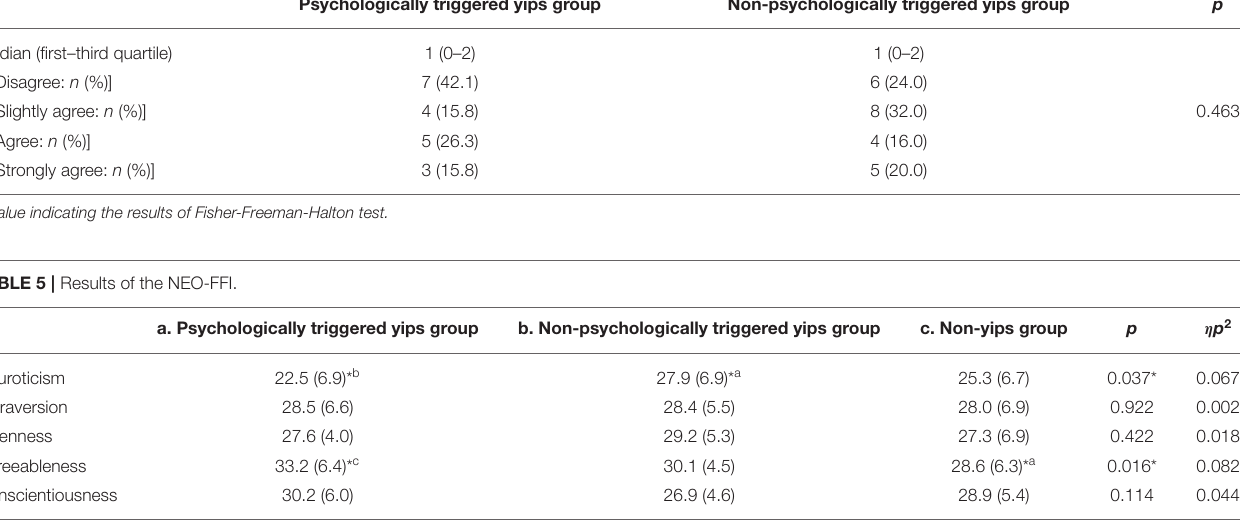
TABLE 4 | Response to a question assessing whether the yips symptoms are more intense in games than in practice. Psychologically triggered yips group Non-psychologically triggered yips group p